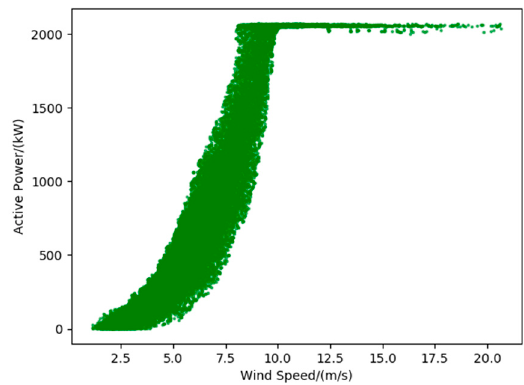
Figure 7. The power curve after data preprocessing.